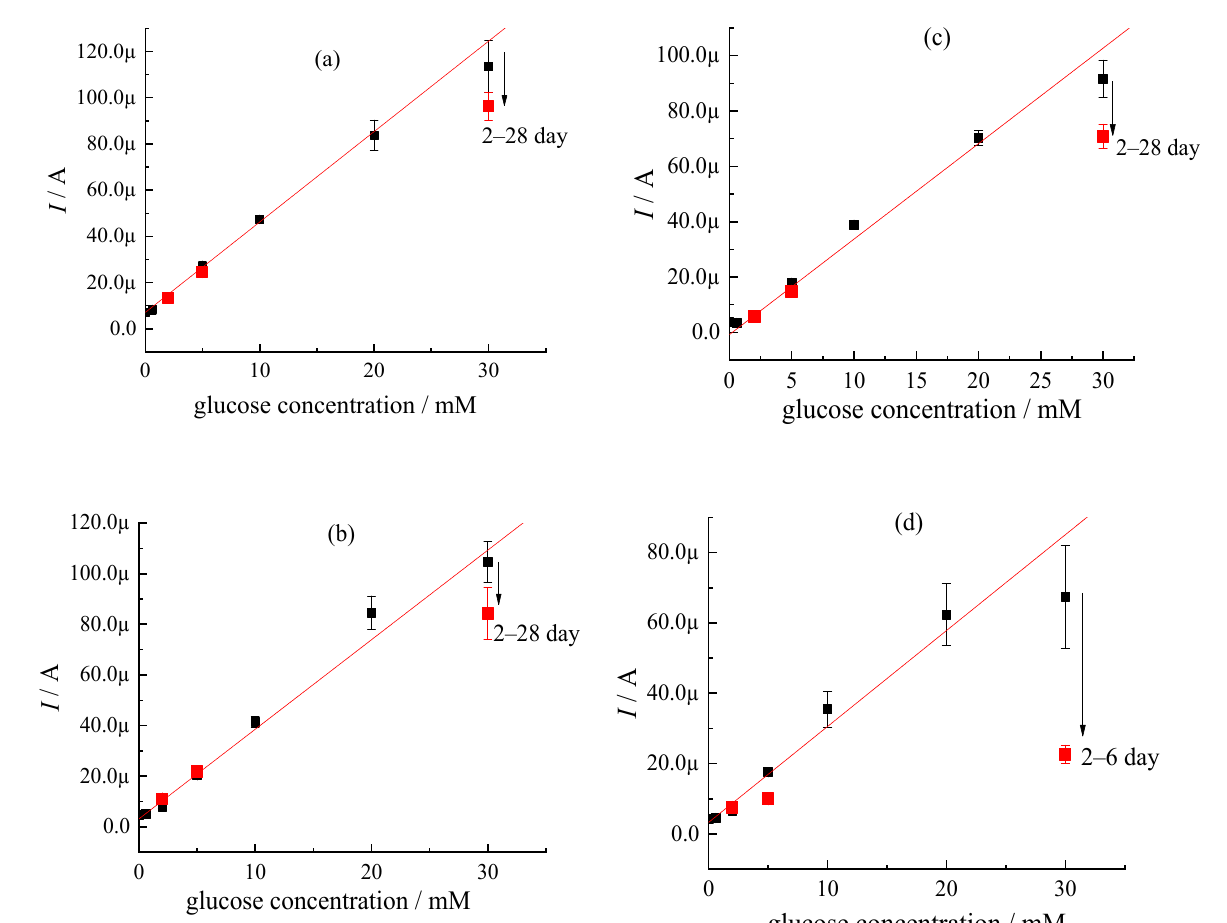
Figure 3. Results of current degradation during storage of selected glucose test strips with various compositions of the functional layer at 55 °C: ( a )–10CMC/25ALG/200FC/24GOx in CitB pH 6.0, ( b )– 10CMC/25ALG/200FC/24GOx in PPBI pH 7.4, ( c )–10CMC/50AS/200FC/24GOx in CitB pH 6.0, ( d )– 10CMC/50AS/200FC/24GOx in PPBI pH 7.4.